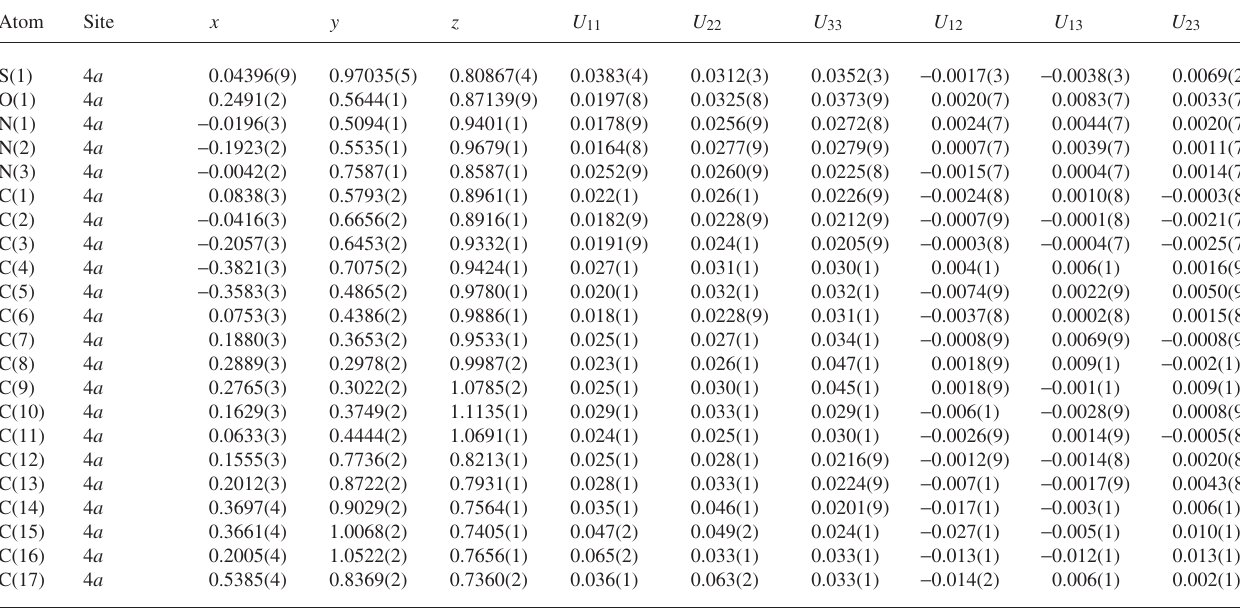
Table 3. Atomic coordinates and displacement parameters (in Å 2 )